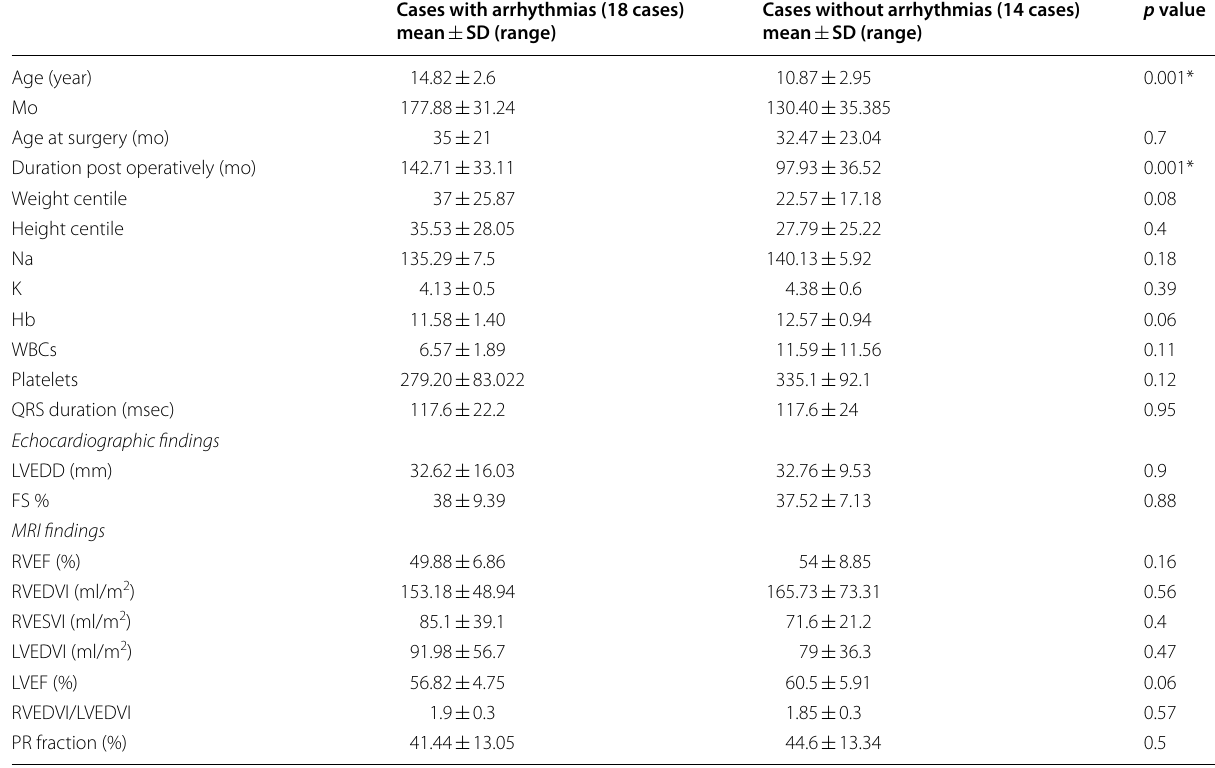
FS fractional shortening, LVEDD left ventricular end diastolic diameter, RVEF right ventricular ejection fraction, RVEDI right ventricular end diastolic volume index, LVEDV left ventricular end diastolic volume, LVEF left ventricular ejection fraction, PR fraction pulmonary regurgitation fraction * p Value is significant if less than